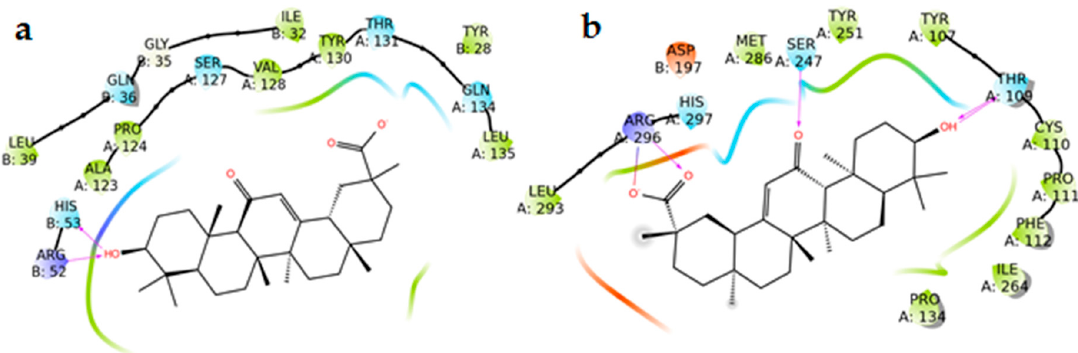
Figure 8. ( a ) 2D panels represent the interactions between AG with the microsomal prostaglandin E synthase 1 (mPGES-1) and 2 (mPGES-2) ( b ) binding sites. Positively charged residues are colored violet, negatively charged residues are colored red, polar residues are colored light blue, hydrophobic residues are colored green. Red-to-blue lines represent salt bridges and H-bonds (side chain) are reported as dotted pink arrows.